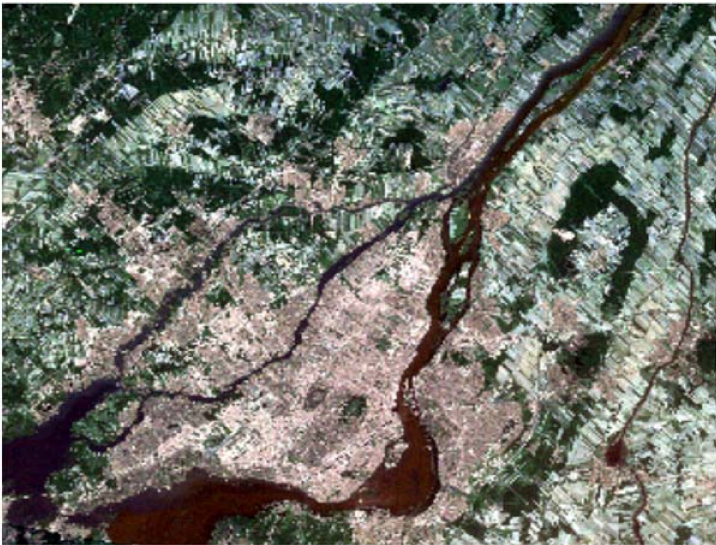
Figure 12. Scene used to compare DNs and ground-based reflectances for five Landsat-5 TM images, two Landsat-7 ETM + images, 1 HRV SPOT image and 1 SPOT 5 HRG